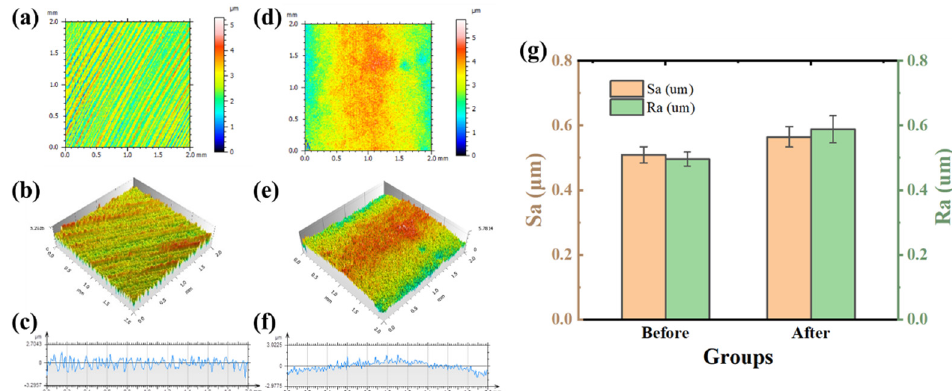
Figure 4. Morphology and roughness of zirconia before and after modification. 2D morphology of zirconia ( a ), 3D morphology of zirconia ( b ), section profile of zirconia ( c ), the 2D morphology, 3D morphology, and section profile of modified zirconia, respectively ( d – f ). The contrast of roughness before and after modification of zirconia ( g ).